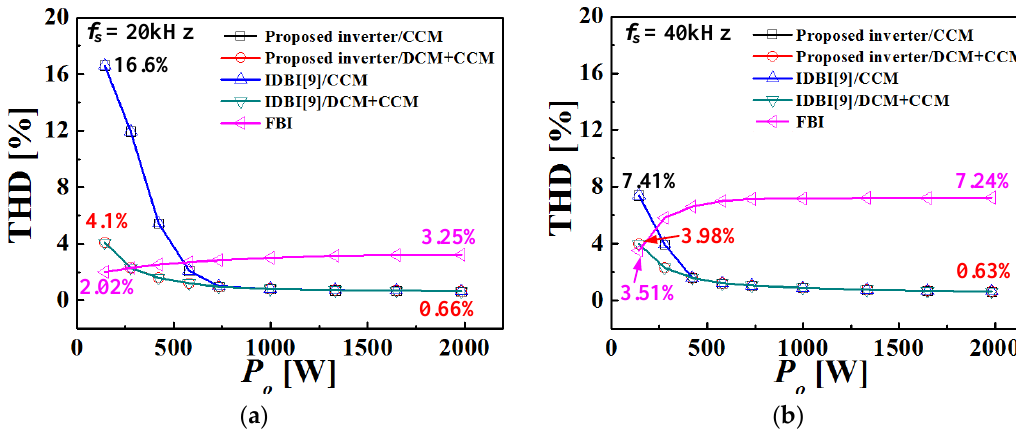
Figure 14. Total harmonic distortion (THD) of i o vs. P o for the experimental inverters operating at ( a ) f s = 20 kHz and ( b ) f s = 40 kHz: measured at V in = 400 V DC and V grid = 220 V AC /60 Hz.